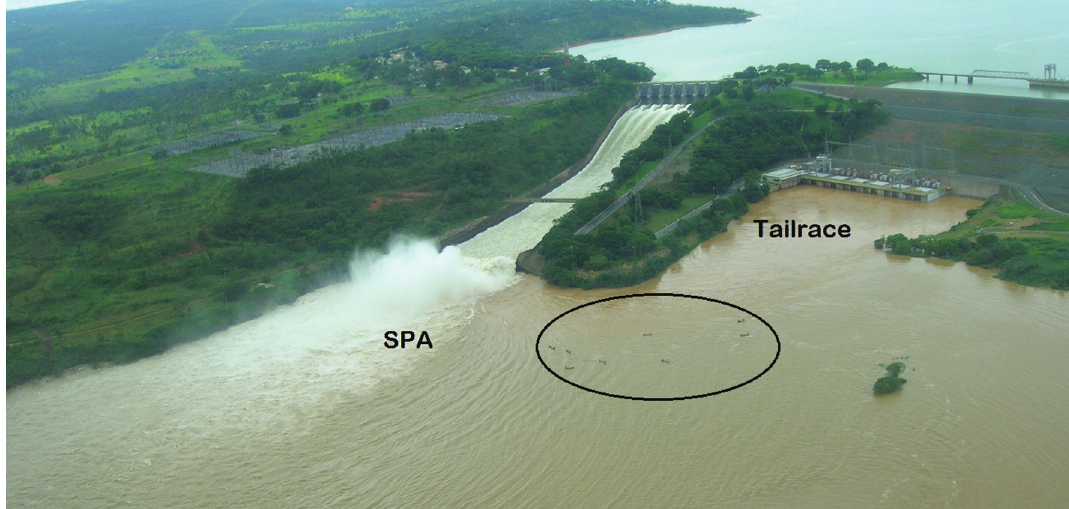
Fig. 1. The spillway plunge pool area (SPA) and the tailrace of Três Marias Dam, São Francisco River, Brazil. During spillage, professional fishers are attracted to the dam area. Eight commercial fishing boats are visible between the island and the SPA in this photograph